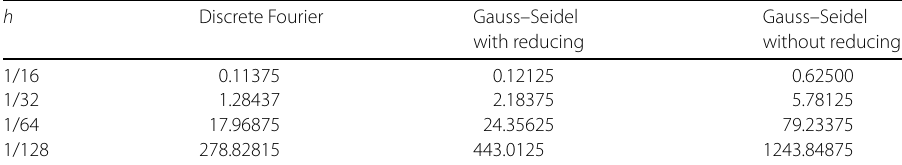
Table 6 CPU times (in seconds) for Problem 3 h Discrete